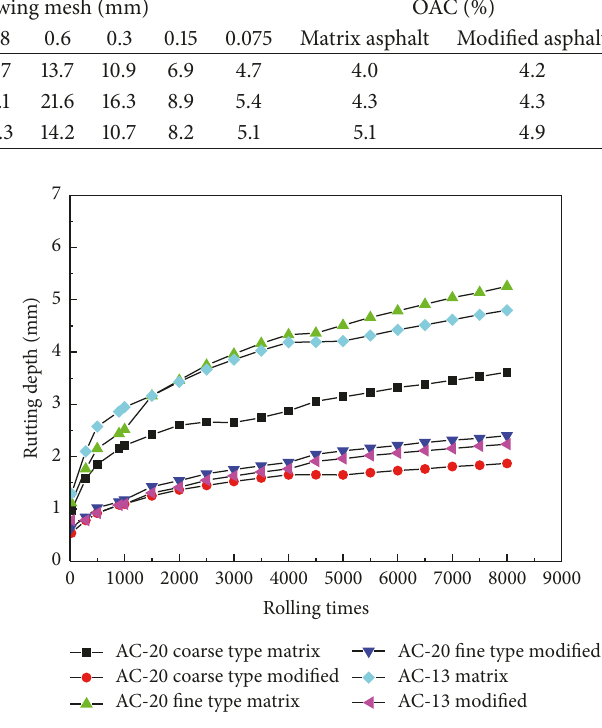
Figure 3: APA rutting depths of asphalt mixtures at 50 ∘ C under air- dry